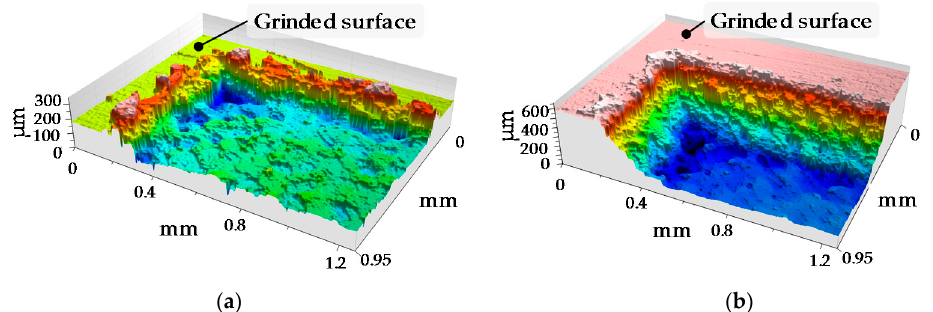
Figure 6. Topographies of the mark after ( a ) One repetition; ( b ) 10 repetitions.